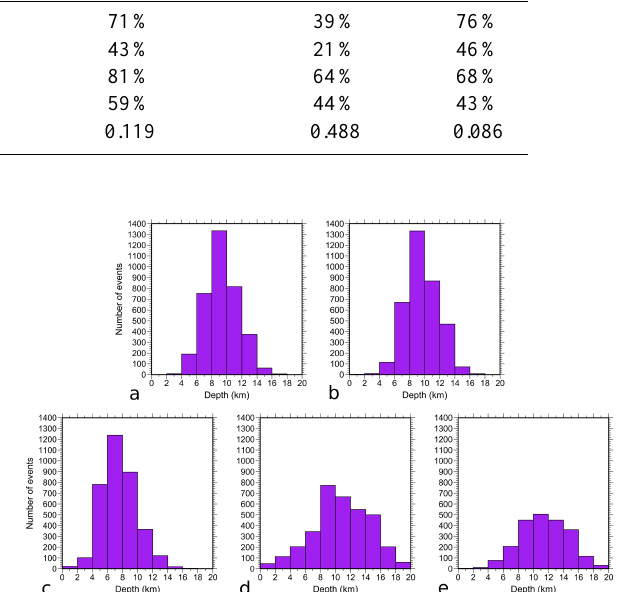
Figure 8. Distribution of hypocentral depth of the relocated Cephalonia 2014 earthquake sequence up to 15 May 2014 for dif- ferent seismic velocity models: (a) the adopted 2-D model, which is a modification of the Haslinger et al. (1999) model; (b) Haslinger et al. (1999); (c) Sachpazi et al. (2000); (d) Hirn et al. (1996); and (e) the model routinely used in the daily seismic monitoring by